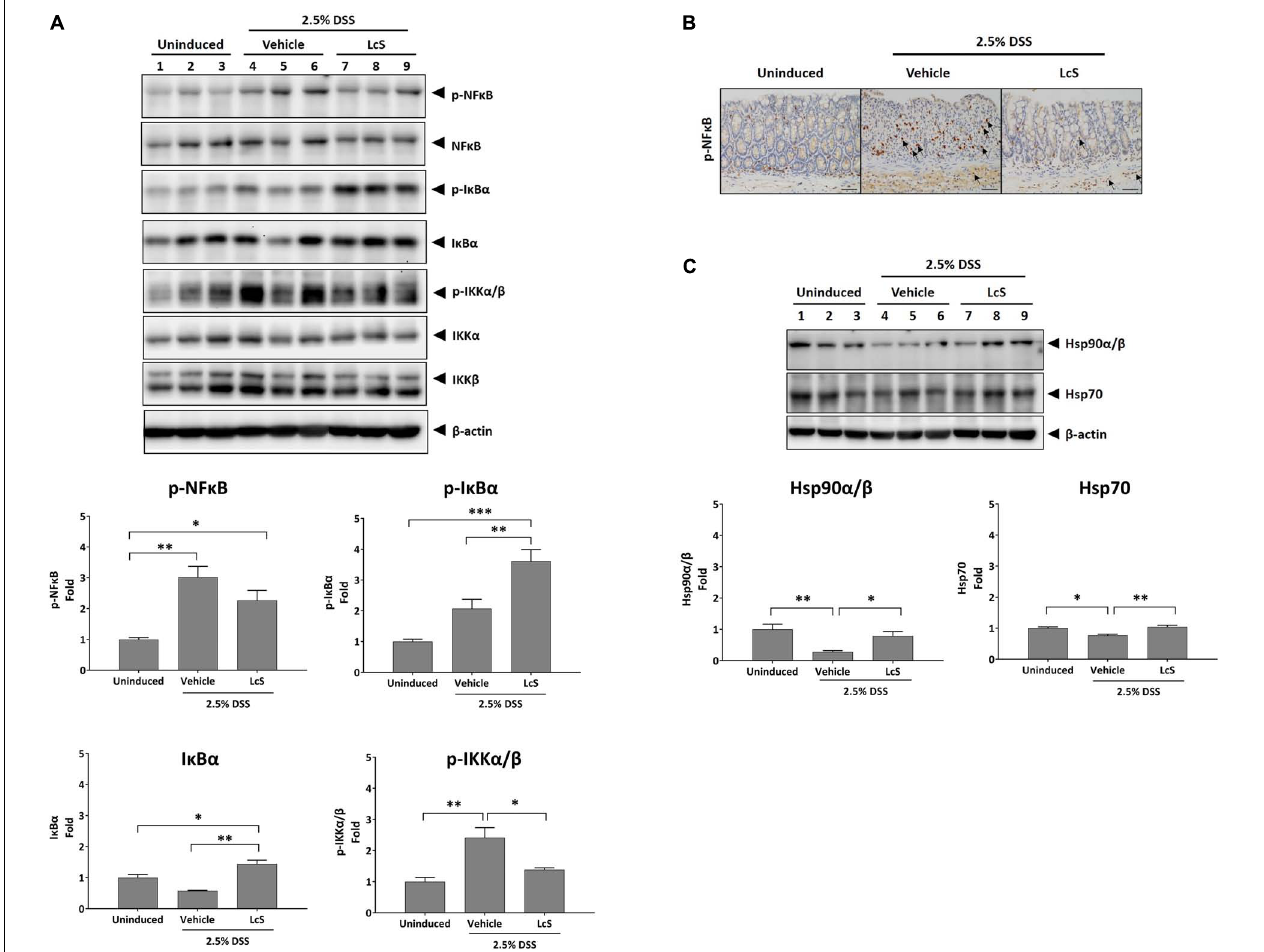
FIGURE 6 | LcS suppressed NF- κ B signaling. Western blot analysis of (A) IKK α / β , I κ B α , NF- κ B, and (C) Hsp90 α / β and Hsp70 in mouse colons. Expression levels of the proteins were normalized to uninduced mice. (B) Representative immunohistochemical staining images of phosphorylated NF- κ B in mouse colons. Arrows indicate colocalization of phosphorylated NF- κ B with nuclei. Data are expressed as mean ± SEM; ∗ p < 0.05, ∗∗ p < 0.01, ∗∗∗ p < 0.001. Scale bars, 25 µ